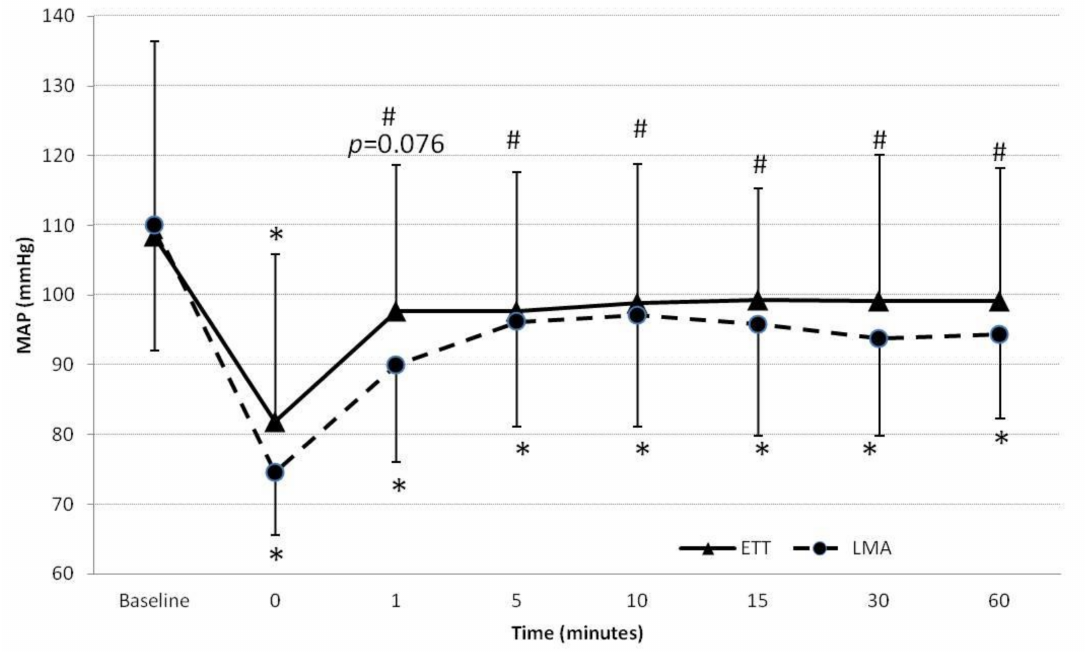
Figure 2. Changes in mean arterial blood pressure (MAP) in patients in the endotracheal tube (ETT) and laryngeal mask airway (LMA) groups. (* p < 0.001 with respect to baseline; # p < 0.05 with respect to baseline). Time 0 was the end of surgery, before